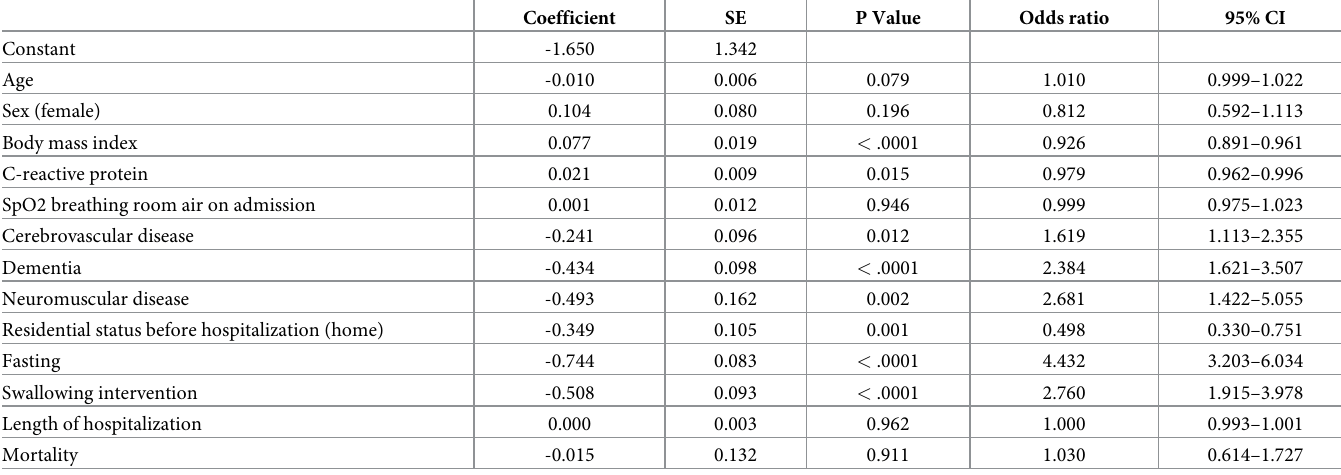
cult to evaluate the effect of swallowing interventions on short-time hospitalization cases. Patient characteristics of the swallowing intervention and non-swallowing intervention group were shown in Table 3. A total of 404 patients met the inclusion criteria, and 208 patients received swallowing interventions (51%). In the swallowing intervention group, the mean age and rate of patients with cerebrovascular disease were significantly higher, fasting period was longer, and oxygen saturation under room air, rate of patients with neuromuscular disease, and AP recurrence rate were significantly lower compared with non-swallowing intervention groups. Correspondingly, the rate of normal diet intake before hospitalization was significantly lower in the swallowing intervention group. The number of patients with the above three comorbidities was 157 in each group. Speech therapists mainly performed swallowing assess- ments and interventions in 86% of cases, including overlapping. Detailed swallowing evaluations through video endoscopy and video fluorography were performed in 20% (41 cases) and 5% (11 cases) of patients with swallowing intervention, respectively. Regarding outcomes of patients, although fasting periods and lengths of hospitali- zation were significantly longer, mortality was significantly lower in the swallowing interven- tion group (8% vs. 16%, p = 0.0178). To reveal the characteristics of swallowing intervention cases, we performed a multivariate analysis. Logistic regression analysis showed that a lower ratio of AP recurrence, a lower ratio Table 2. Factors characterizing aspiration pneumonia by logistic regression